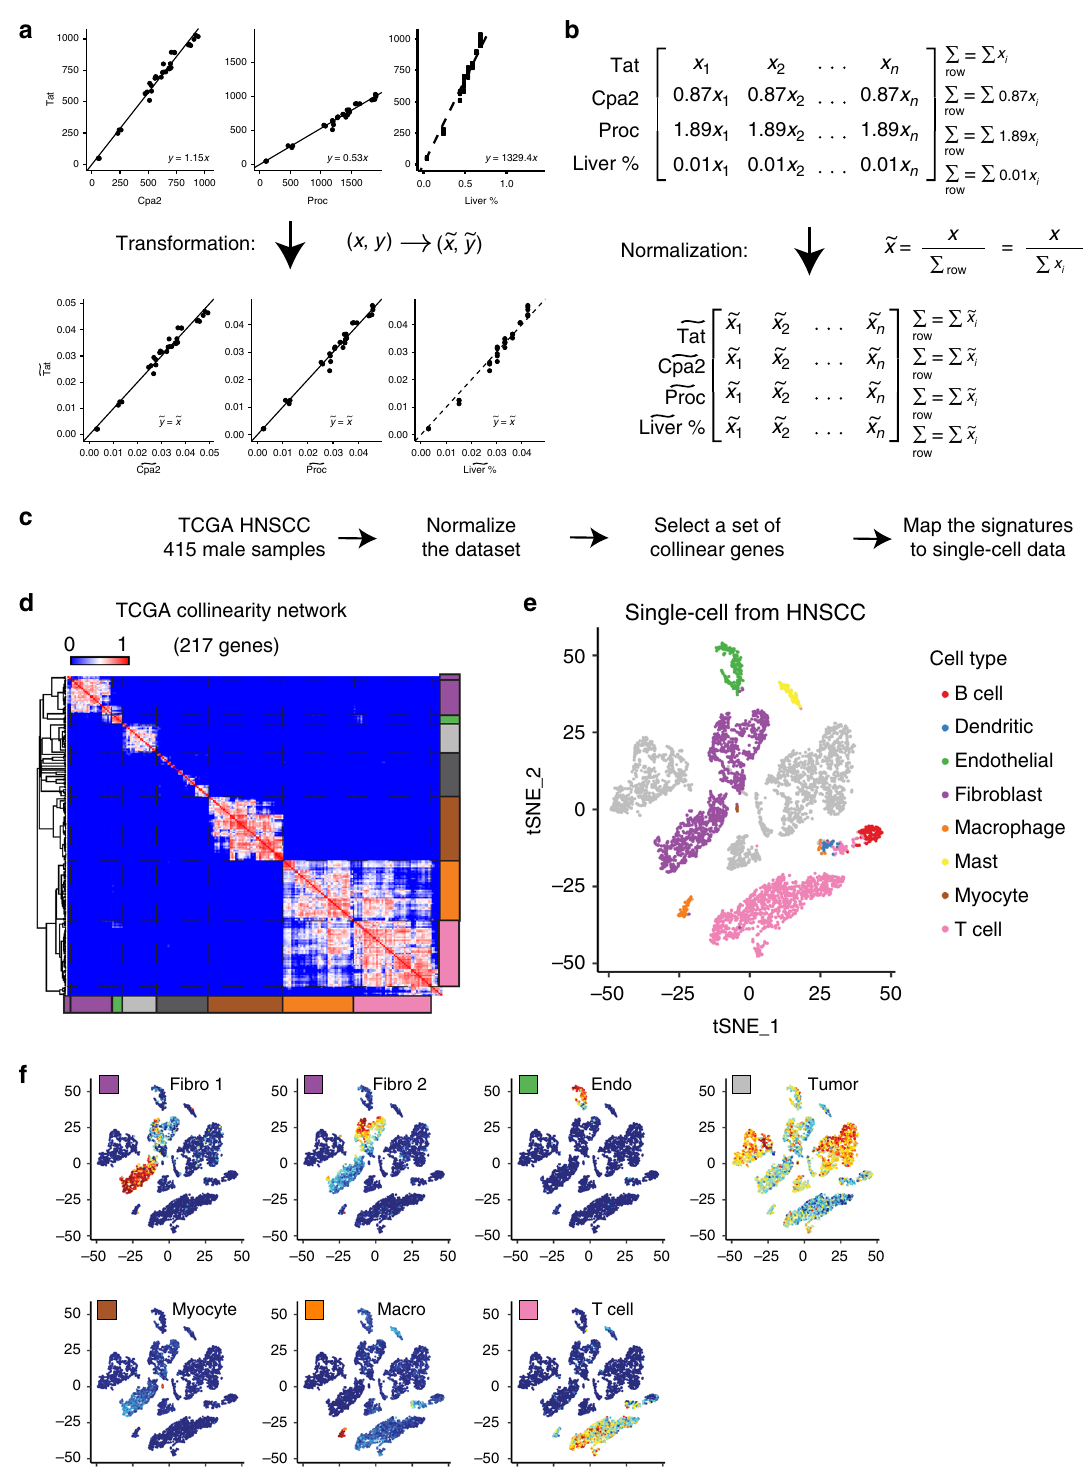
Fig. 2 Gene collinearity of bulk HNSCC TCGA data reveals pure cell types consistent with scRNA-seq data. a Regression lines and coef fi cients before and after normalization. Regression line coef fi cient will change to unity in case of true signature genes. b In case of true signature genes normalized vectors will be equal. c Work fl ow for TCGA samples analysis and validation with the scRNA-seq data. d Left: TCGA collinearity network after fi ltration: seven clusters of highly collinear genes and dark-gray cluster that contains small 2 – 3 genes clusters. e Single-cell data for HNSCC reanalyzed (GSE103322). f Expression pro fi les of genes in seven clusters in the scRNAseq dataset, color represents averaged Z -score for genes in cluster from blue (min) to red